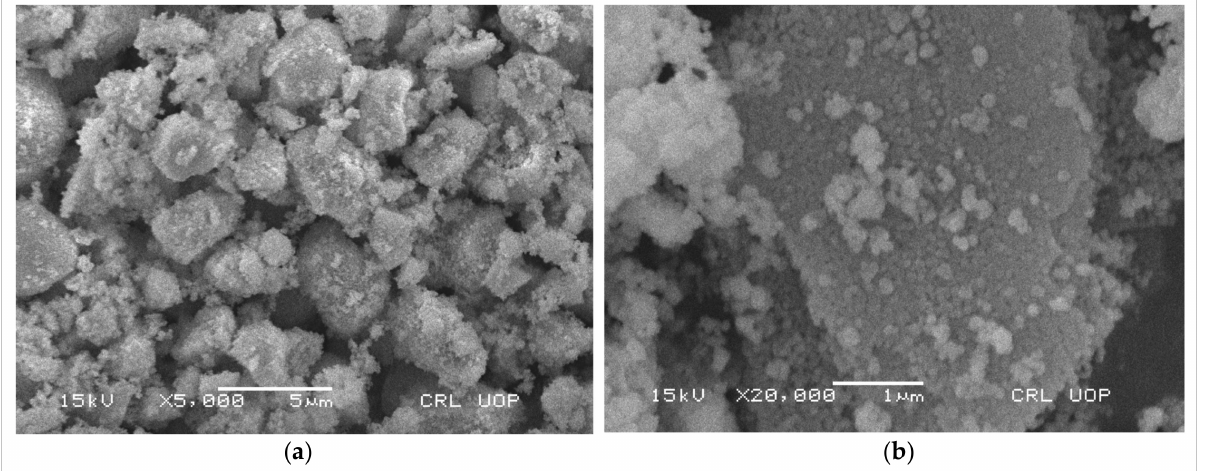
Figure 3. SEM images of Pd/ZrO 2 at different magnifications of: ( a ) 5000 × , ( b ) 20,000 × .